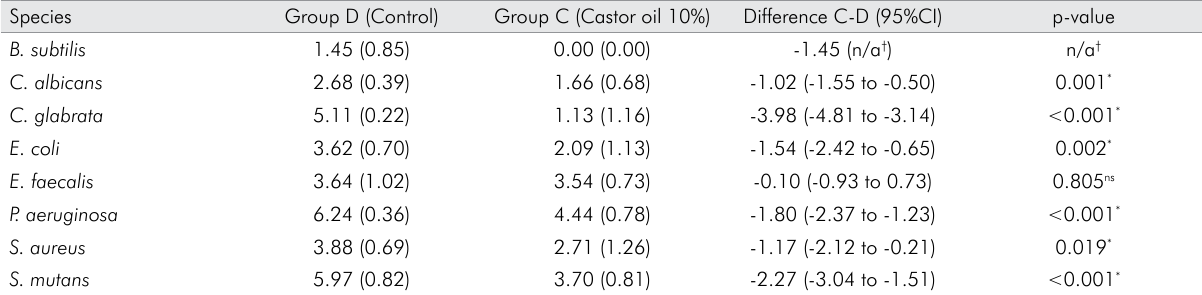
Table. Mean values and standard deviation for species, in log10(CFU+1)/mL, average differences among the groups and Student’s t-test values for independent